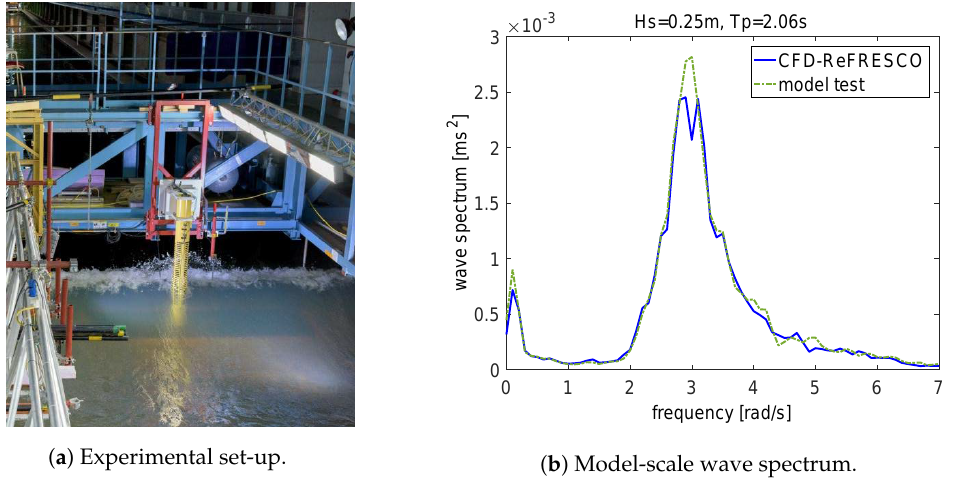
Figure 7. Wave spectrum derived from wave measurements and CFD calculations on steep and breaking waves approaching a fixed monopile. Figure based on the same data as a figure in